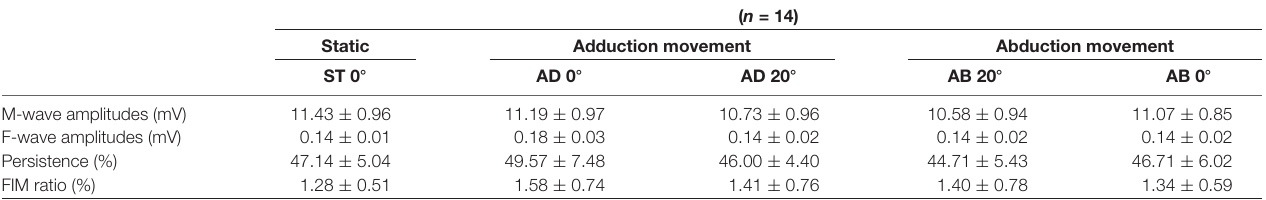
TABLE 2 | Mean M-wave amplitude, F-wave amplitude and persistence and F/M ratio during passive movement in Experiment